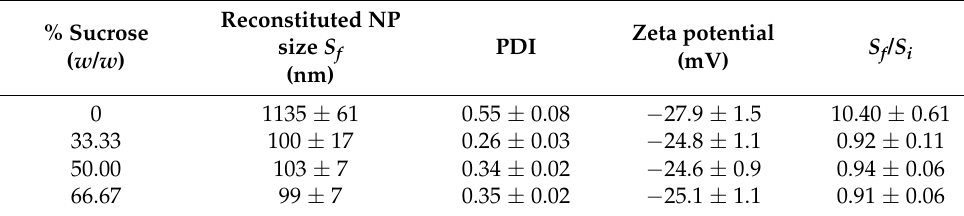
Table 1. Aqueous reconstitution of the lyophilized CUR-BSA nanoplex (NP).